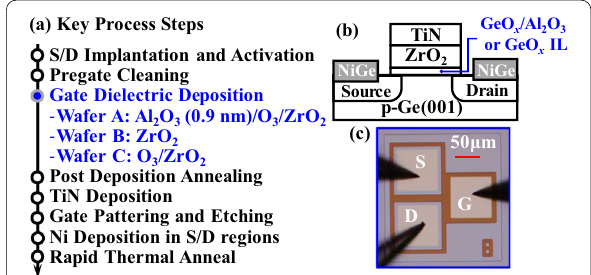
Fig. 1 a Key process steps for fabricating Ge nMOSFETs. b Cross-sectional schematic and c microscope image of the fabricated devices